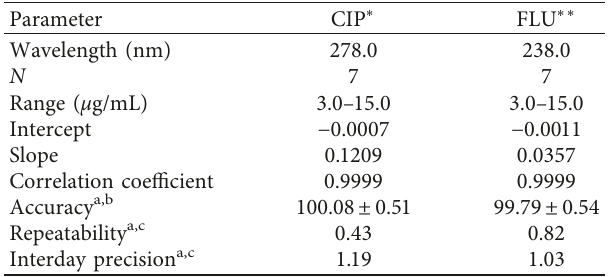
Figure 6: The spectra obtained by using the EXRS method. (a) A mixture containing 5.0 μ g/ml of each (CIP) and FLU; (b) the mixture after divided by 12.0 μ g/mL of FLU ′ ; (c) the mixture after subtracting the constant; (d) the pure (CIP) obtained after multiplied by FLU ′ Table 2: Assay parameters and validation sheets for pure cited drugs at their maxima.